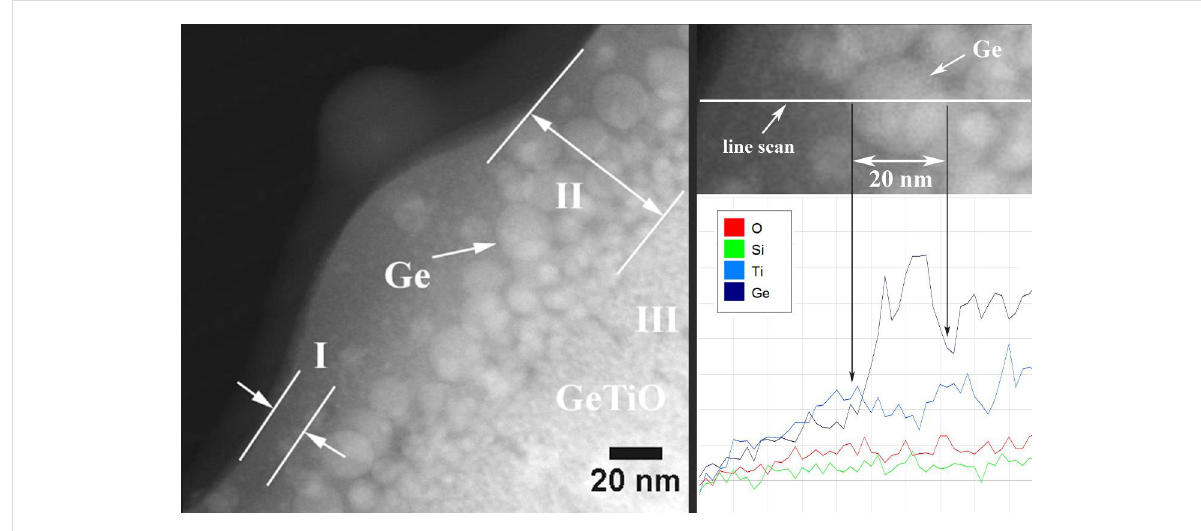
Figure 5: STEM-HAADF image (left) and a detail from the same image correlated with line scan EDX analyse (right) performed on the XTEM spec- imen prepared from the GeTiO film irradiated with 100 laser pulses at a fluence of 15 mJ/cm 2 .